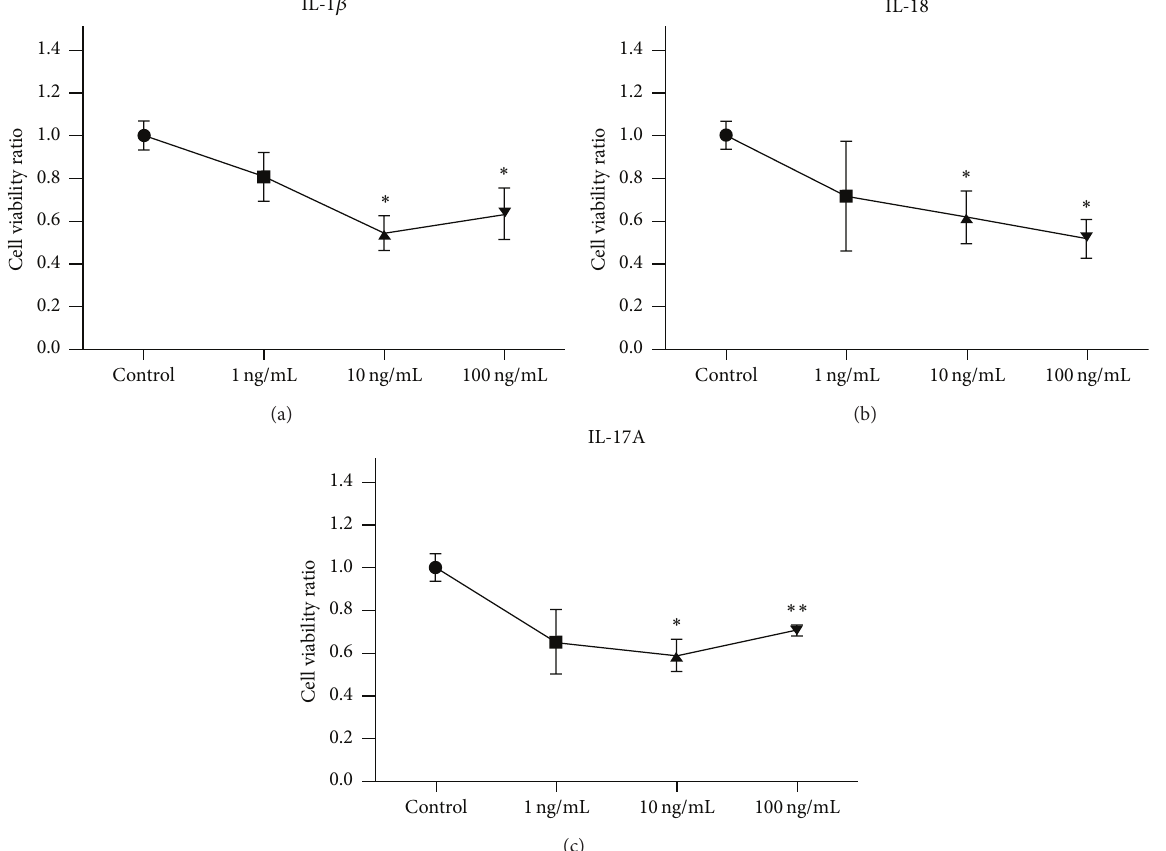
Figure3:RSCsviabilitywasdetectedwithMTTassay.TheRSCsweretreatedwithIL-1 𝛽 (a),IL-18(b),orIL-17A(c)atdifferentconcentrations. ∗ 𝑝 < 0.05 ; ∗∗ 𝑝 < 0.01 compared to control.